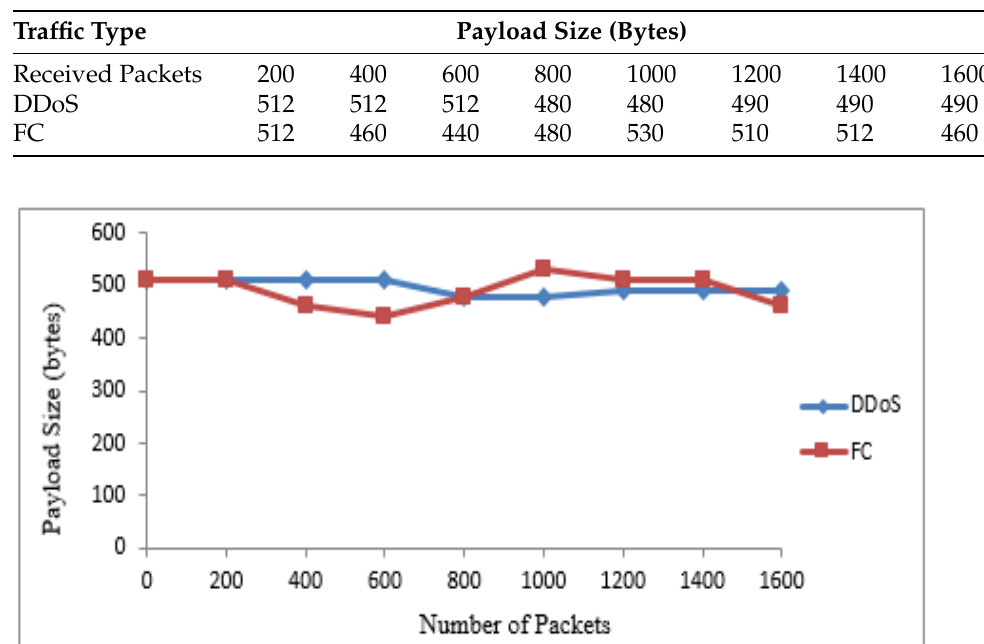
Figure 4. Discrimination of DDoS attack from FC based on IAT. Table 5. DDoS attack from FC based on the size of payload.